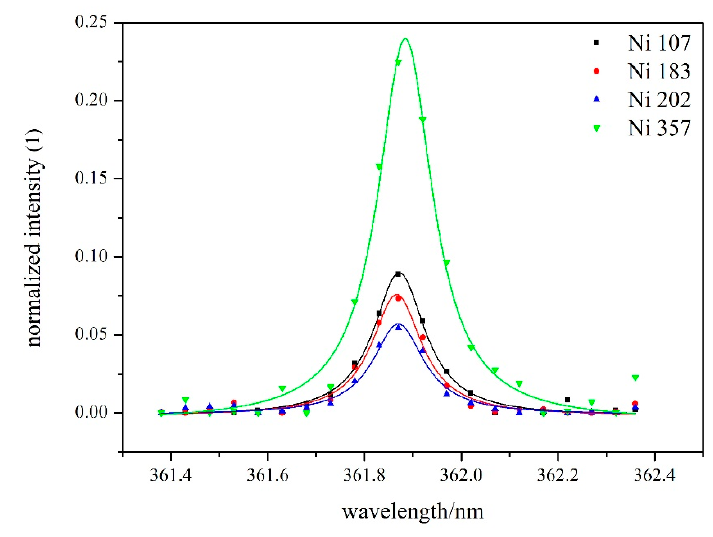
Figure 9. Results of Lorentz fitting of Fe I 361.877 nm.